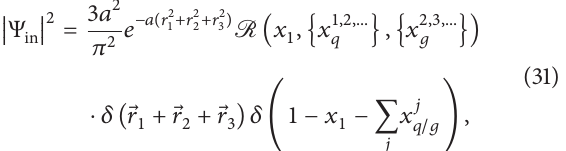
Here, ⃗𝑟 𝑖 𝑞/𝑔 and 𝑥 𝑖 𝑞/𝑔 are the coordinates and fractional momenta of the valence/sea